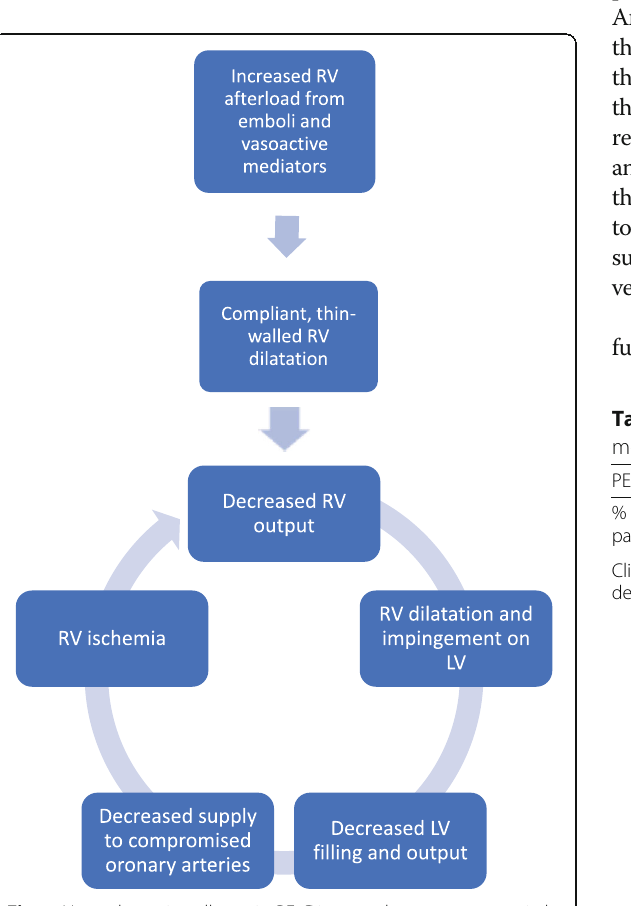
Fig. 7 Hemodynamic collapse in PE. Diagram demonstrates a spiral resulting in hemodynamic collapse in patients with massive and submassive PE